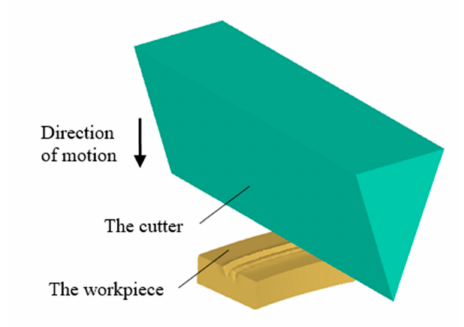
Figure 3. Geometry model of the workpiece and the cutting tool in